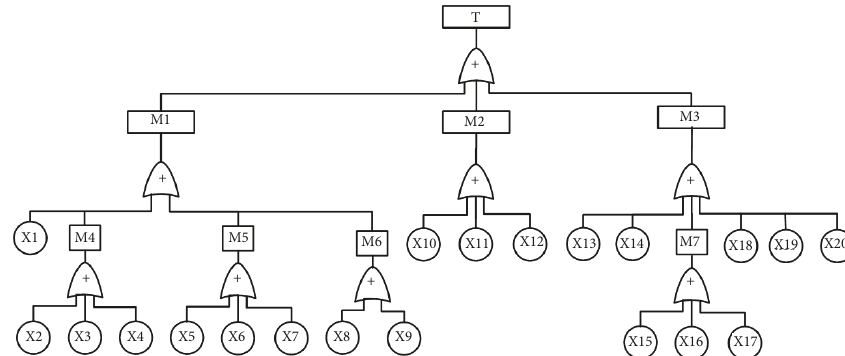
Figure 3: Fault tree of an aircraft landing gear retraction system, where T is a landing gear retraction system fault; M1 is an actuating cylinder fault; M2 is a control system fault; M3 is a hydraulic system fault; M4 is a piston rod fault; M5 is a sealing ring fault; M6 is an end eyelet fault; M7 is a hydraulic pump fault; X1 is a cylinder fracture; X2 is a seized piston rod; X3 is a loose piston rod; X4 is a fractured piston rod; X5 is a mechanically damaged sealing ring; X6 is an aging and cracking sealing ring; X7 is a chemically corroded sealing ring; X8 is an eyelet bolt fracture; X9 is an eyelet rotation; X10 is the failure of the pressure switch; X11 is the failure of the electromagnetic switch; X12 is the failure of the safety valve; X13 is oil leakage from the hydraulic line; X14 is an air lock fault; X15 is a fracture of the pump plunger piston spring; X16 is oil leakage from the pump rotary joint; X17 is a damaged pump motor; X18 is oil contamination; X19 is a broken hard pipe; X20 is a break in the accumulator.